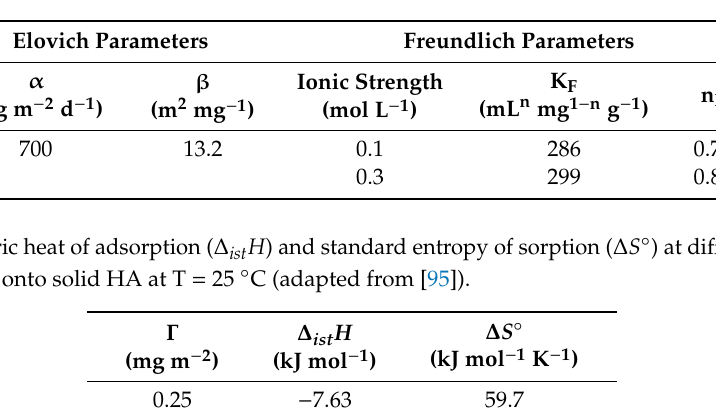
Table 5. Elovich kinetic constants and Freundlich coe ffi cients for the sorption of atrazine onto solid HA (adapted from [95]).